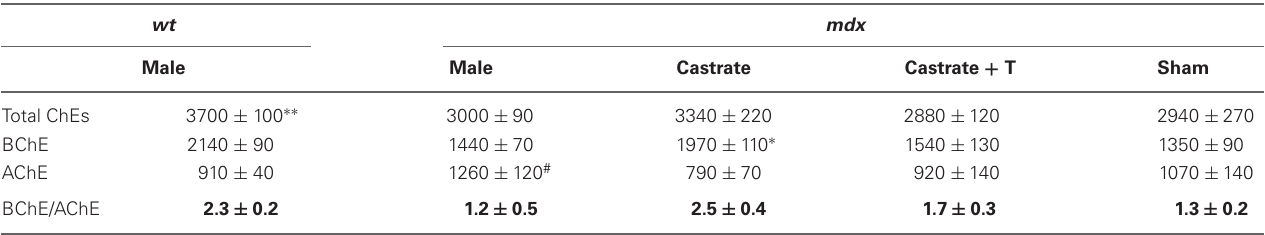
Table 3 | Changes in BChE and AChE activities in the sera of adult wt and mdx adult male mice before and after orchidectomy, and after